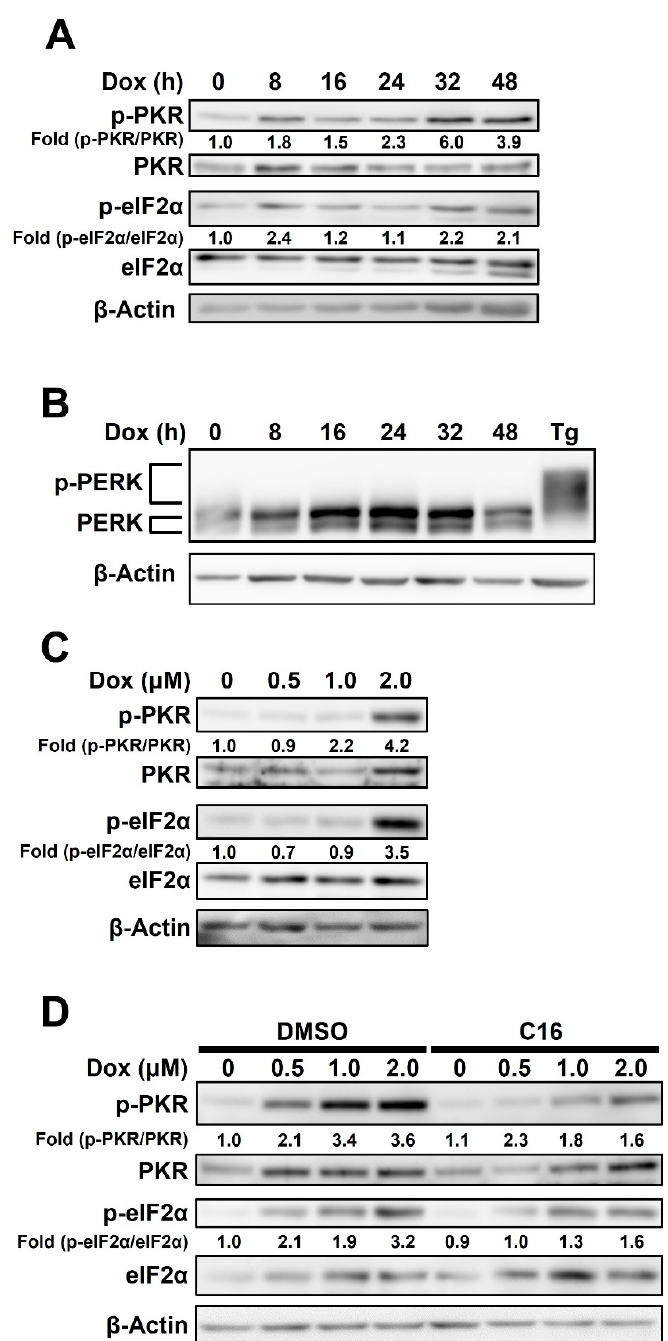
Figure 2. Doxorubicin-mediated activation of protein kinase R (PKR), but not PKR-like ER kinase (PERK), is responsible for eukaryotic initiation factor 2 alpha (eIF2 α ) phosphorylation in HCC1143 cells. ( A , B ) Cells were treated with 2 µM doxorubicin for the indicated time period and analyzed via immunoblotting using antibodies against phosphorylated form of eIF2 α (p-eIF2 α ), eIF2 α , phosphorylated form of PKR (p-PKR), PKR, PERK, and β -Actin. Tg was used as a positive control. Fold change is the ratios of p-PKR to PKR and p-eIF2 α to eIF2 α . ( C ) Cells were treated with the indicated concentrations of doxorubicin for 32 h and analyzed via immunoblotting using specific antibodies against p-PKR, PKR, p-eIF2 α , eIF2 α , and β -Actin. ( D ) Cells pretreated with or without 0.5 µ M C16 for 1 h were treated with the indicated concentrations of doxorubicin for 32 h and analyzed via immunoblotting using specific antibodies against p-PKR, PKR, p-eIF2 α , eIF2 α , and β -Actin. Fold change is the ratios of p-PKR to PKR and p-eIF2 α to eIF2 α